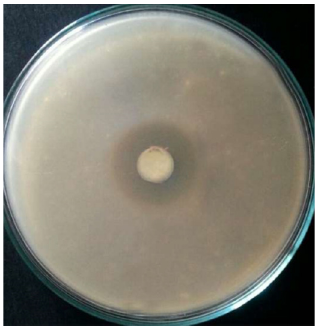
Fig. 7. Zone of inhibition of silver nanoparticles synthesized by Pseudomonas sp . H64 against A.